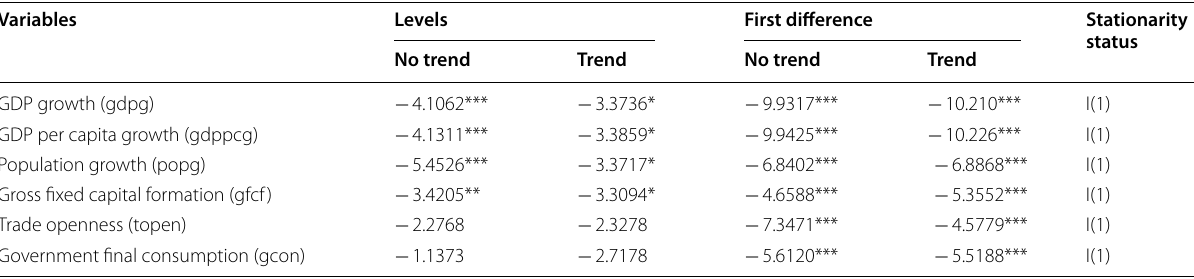
*** ,**,* represent significance level at 1%, 5% and 10%, respectively No Trend implies with constant and no trend, Trend implies with constant and trend